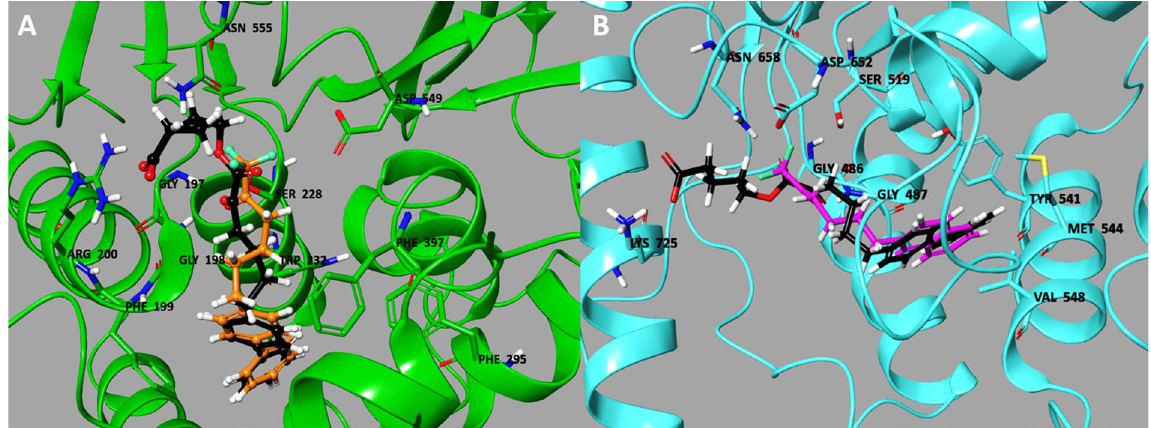
Figure 7. Binding mode of inhibitor 17f in the active site of ( a ) GIVA cPLA 2 and ( b ) GVIA iPLA 2 .